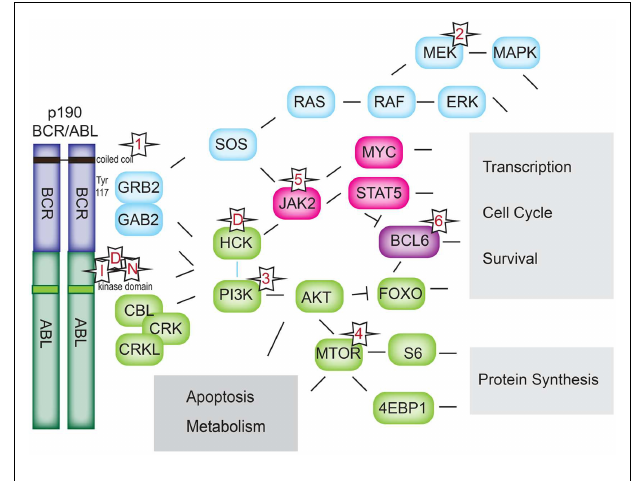
FIGURE 3 | BCR–ABL1 signaling pathways . Downstream signaling pathways activated by BCR–ABL1. Numerical references 1–6 denote classes of inhibitors in Table 1 . I: imatinib; D: dasatinib, N: